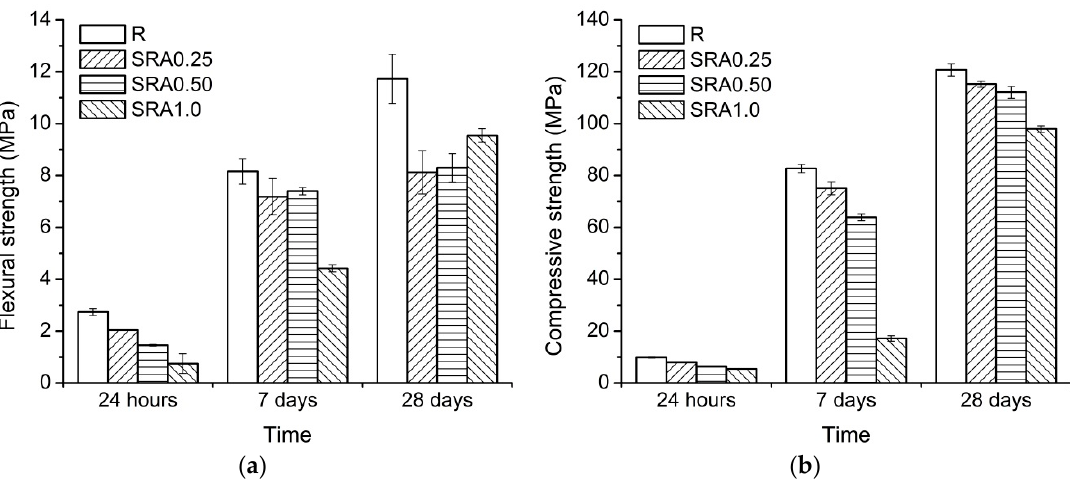
Figure 2. Effect of SRA on ( a ) flexural strength and ( b ) compressive strength development of AAS-based mortars; error bars correspond to a standard error of the mean.